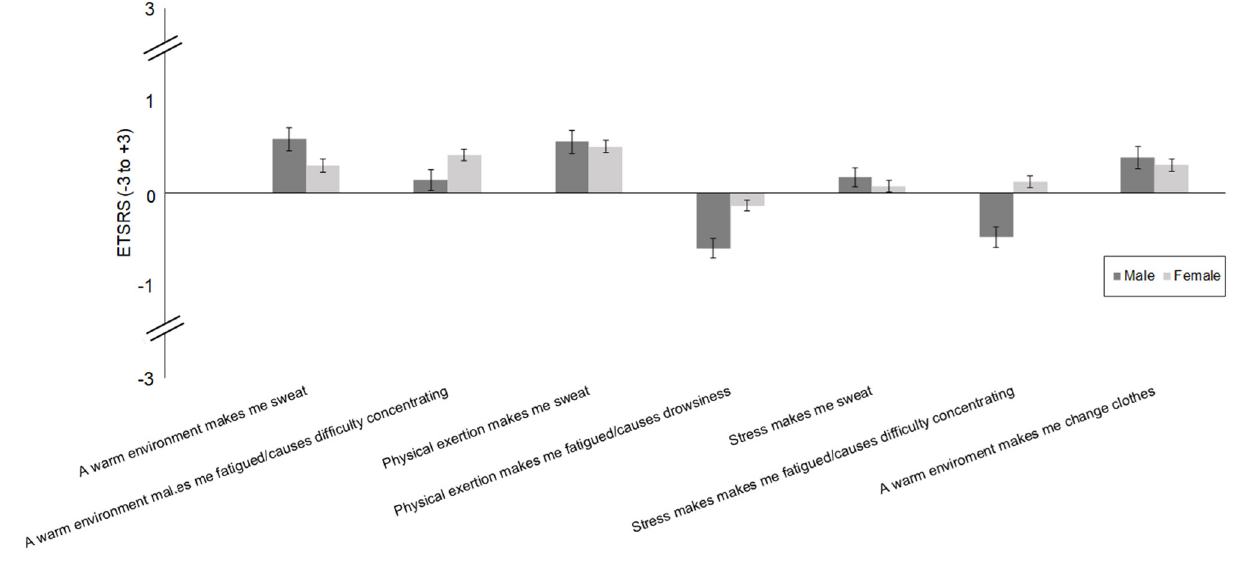
physical activity per week, but did not differ from non-depressed individuals regarding their